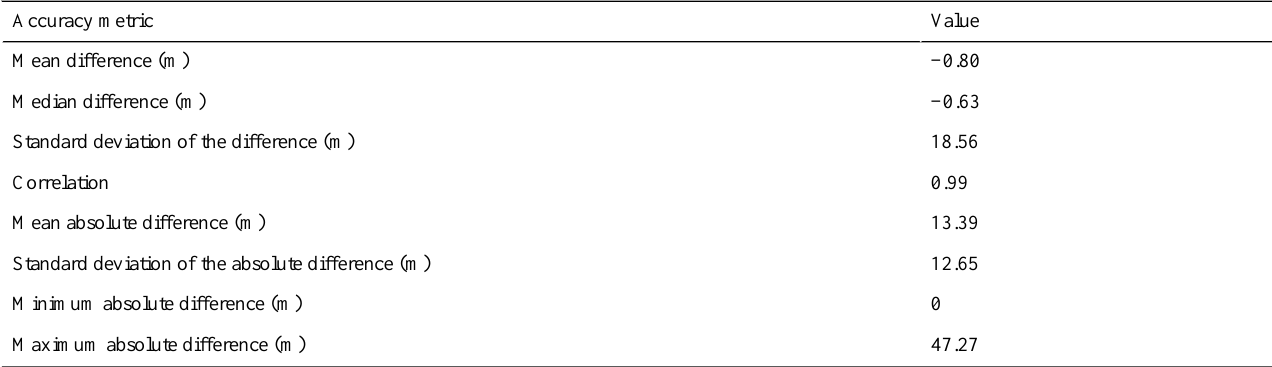
Table 4. Accuracy metrics of the outdoor algorithm. By difference, we mean the difference between the estimated distance as computed by the app and the reference distance, as measured by the trundle